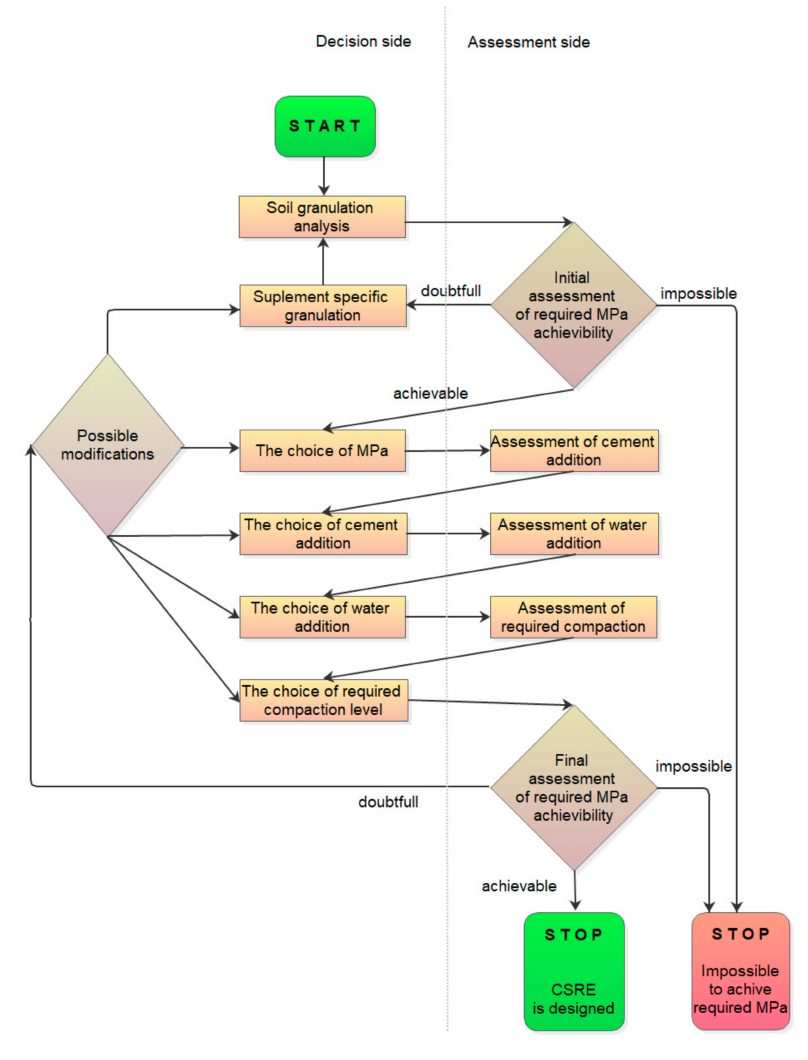
Figure 10. Proposed algorithm for designing